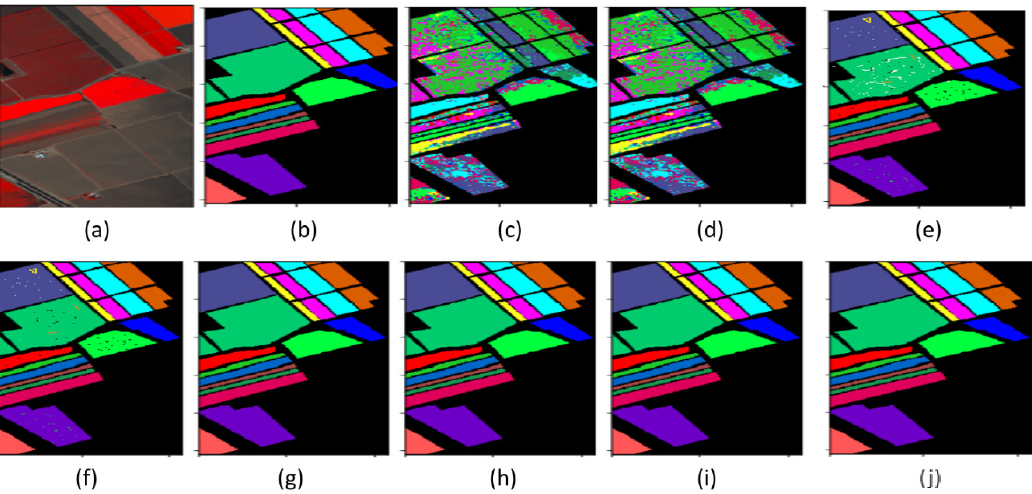
Figure 9. Salinas classification maps: ( a ) RGB (bands 57, 19, and 9) image; ( b ) ground truth; ( c ) SVM; ( d ) 2-D CNN; ( e ) 3-DCNN; ( f ) SSRN; ( g ) HybridSN; ( h ) DPSCN; ( i ) SE-DenseNet with cutout; and ( j ) SE-AB-DenseNet with cutout.